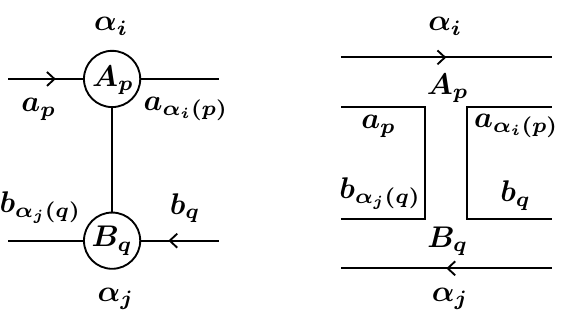
Figure 20 . (Left) Usual Feynman graph as the Cayley graph of ( (cid:11); W ). (Right) The Feynman graph in the double-line notation as the Cayley graph of ( (cid:19) (cid:11) ; W ), representing the Wick-contraction h ((cid:8) A p ) a p a i ((cid:8) B q ) b q b (cid:11)j ( q ) (cid:11)i ( p )